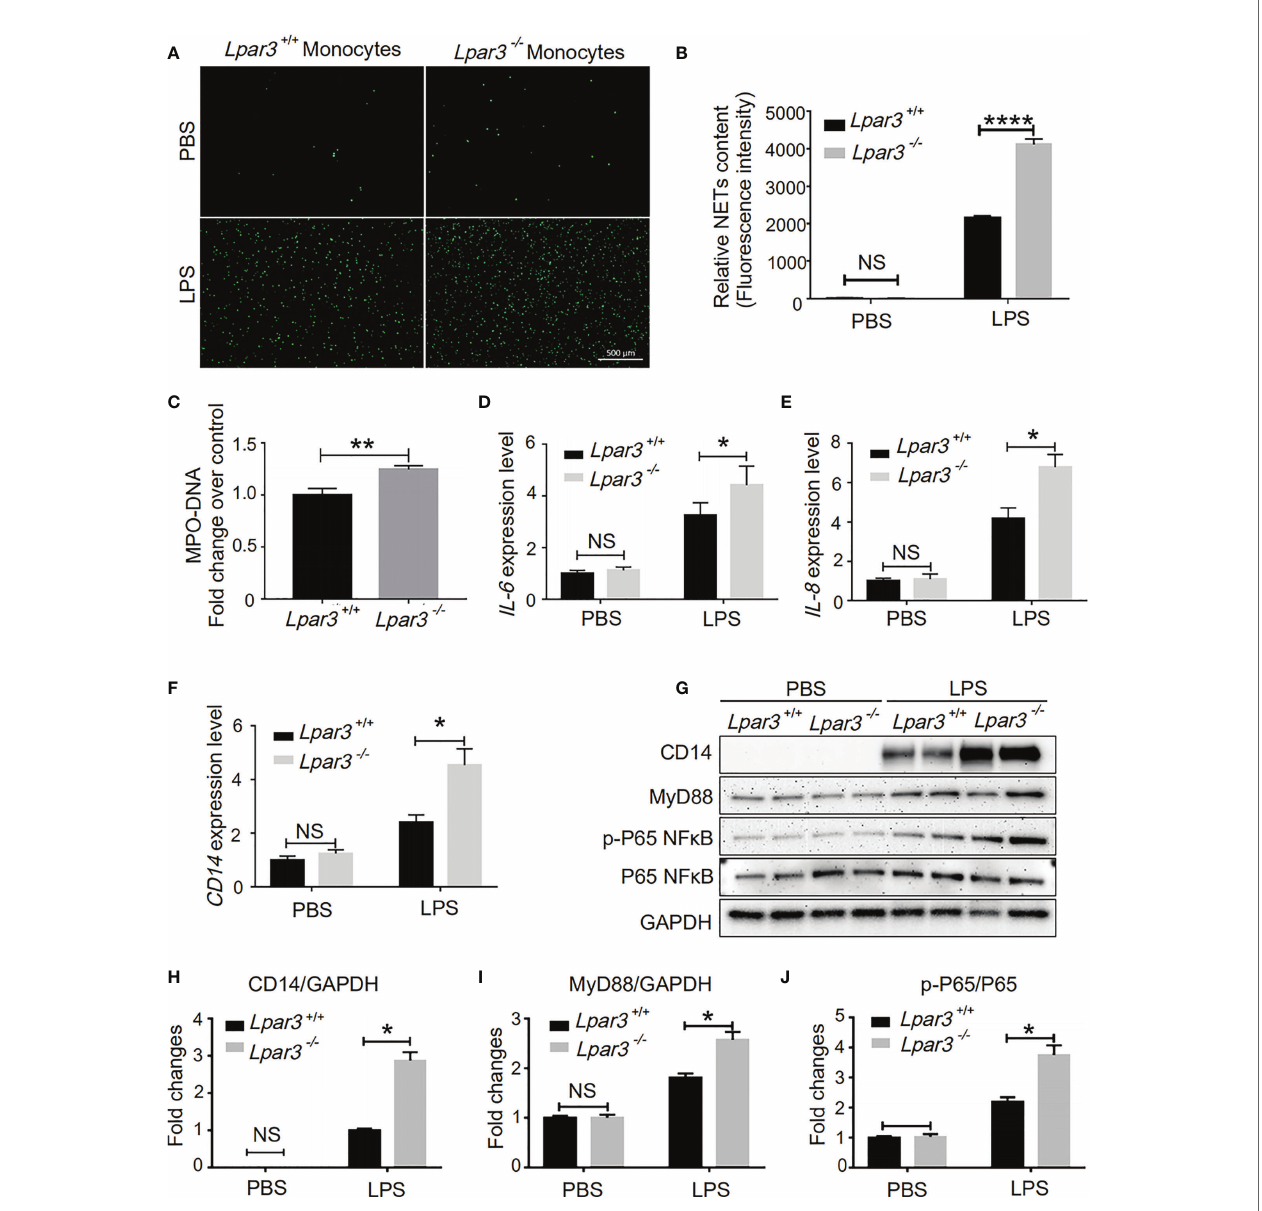
FIGURE 6 | LPA 3 works on monocytes in sepsis. (A, B), SYTOX Green staining of NETs induced by WT or Lpar3 -/- monocytes with LPS. Neutrophils co-cultured with Lpar3 -/- monocytes were induced more NETs after LPS stimulation than neutrophils co-cultured with WT monocytes (n = 6 for each group), Bar = 100 m m. (C), The level of MPO-DNA complexes in the cell culture supernatant after LPS treatment. Neutrophils co-cultured with Lpar3 -/- monocytes had higher levels of the MPO-DNA in the cell culture supernatant than in that of WT controls (n =9 for each group). (D – F), qRT-PCR analysis of gene expression in monocytes. LPA 3 de fi ciency increased the expression of IL-6, IL-8, and CD14 in monocytes from mice with sepsis (n = 6 for each group). (H – J), Western blot analysis of protein levels in monocytes. The expression of monocyte protein CD14, MyD88, and p-P65 NF k B increased in Lpar3 -/- mice with sepsis (n = 6 for each group). *P < 0.05, **P < 0.01, ****P < 0.00001. NS, no signi fi cance. LPA 3 , lysophosphatidic acid receptor 3; WT, wild-type; LPS, lipopolysaccharide; NETs, neutrophil extracellular